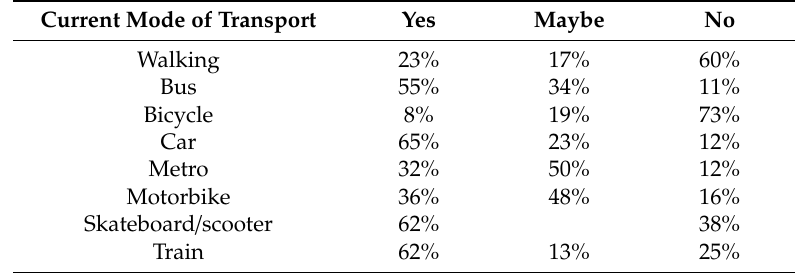
Table 9. Percentage of students who would change their mode of transport to another sustainable